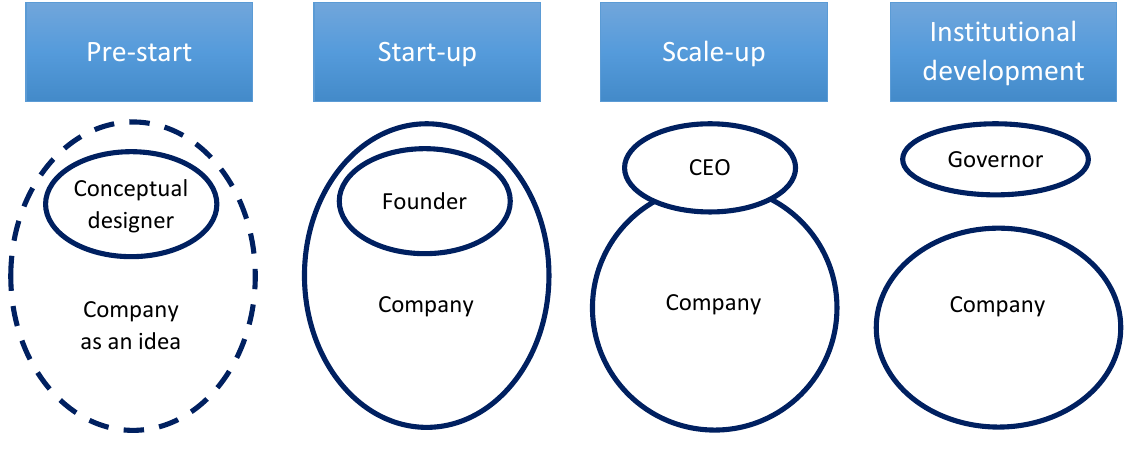
Figure 1. Entrepreneur-company